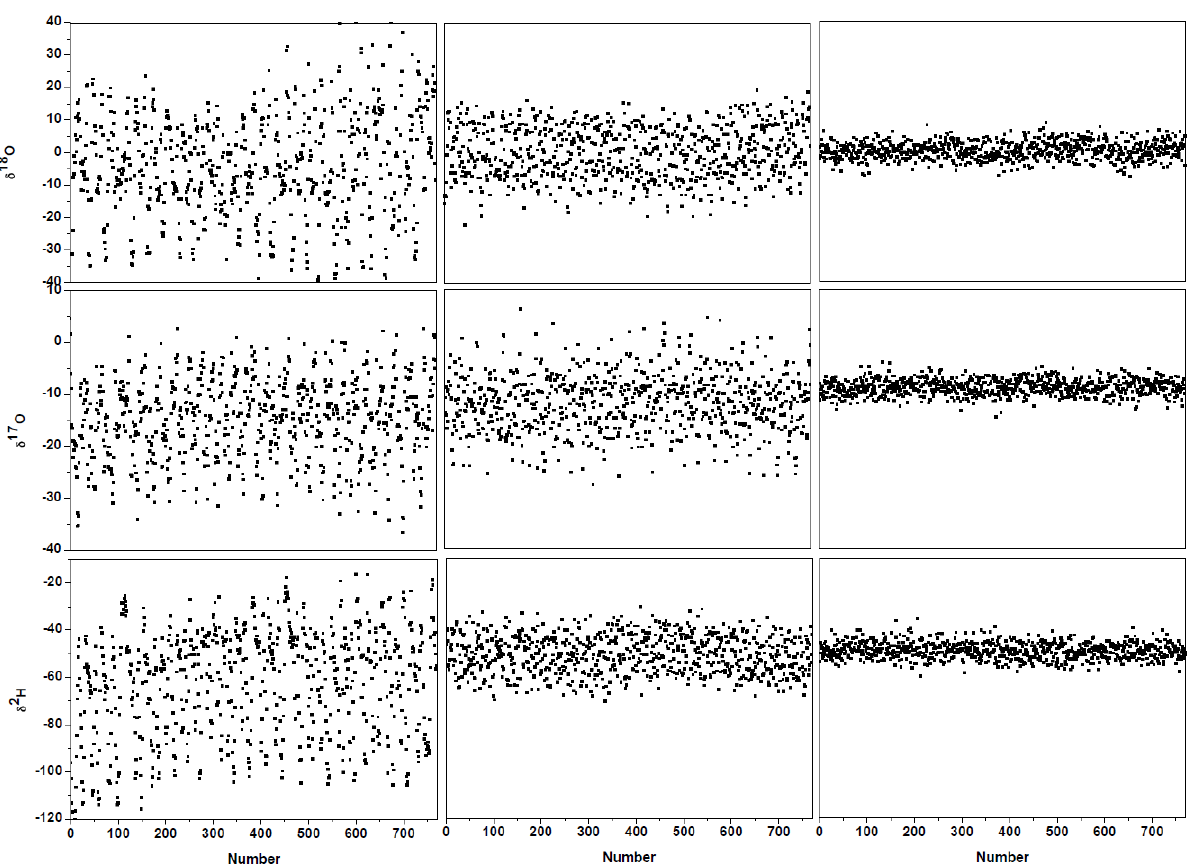
Figure 5. The 18 O/ 16 O, 17 O/ 16 O and D/H isotope ratios obtained with different baseline modelings. Left panel: baseline described with a 4th-order polynomial. Central panel: baseline modeled using a 4th-order polynomial and a Fourier series function (with three main frequency components). Right panel: no oscillation structure in original spectrum